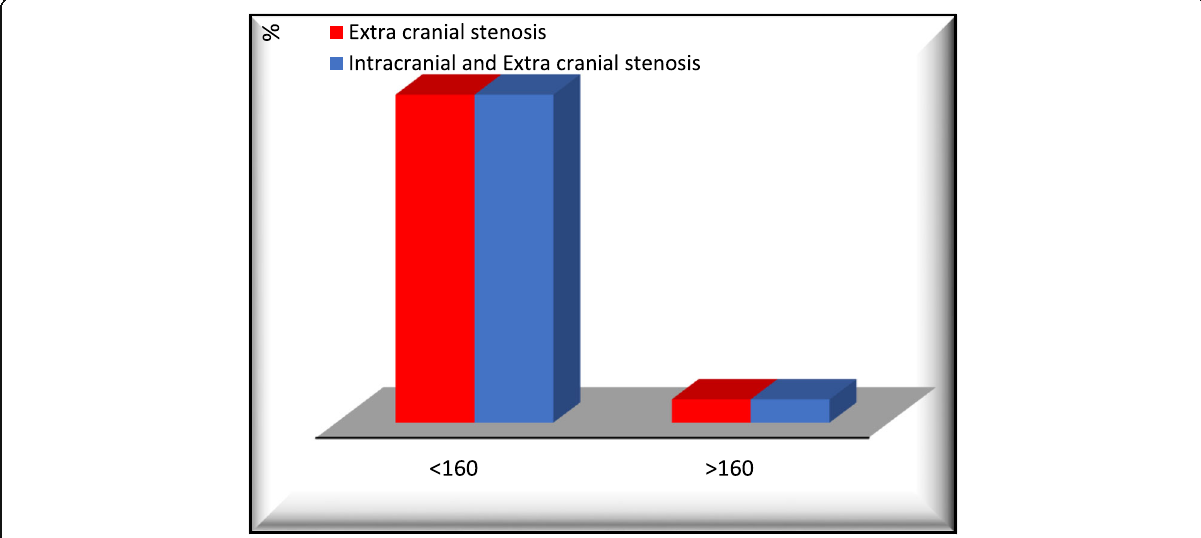
Fig. 1 PSV in both groups. Regarding those 30 patients with acute stroke, cerebral hemodynamics were assessed by transcranial Doppler by the assessment of both PSV and EDV in ipsilateral MCAs; in the 15 patients with extracranial stenosis, only one patient (6.67%) showed increased PSV over 160 cm/s, with mean 59.38 ± 22.25, while in 15 patients of both intracranial and extracranial stenosis, also only one patient (6.67%) showed increased PSV in MCA over 160 cm/s with mean 68.133 ±